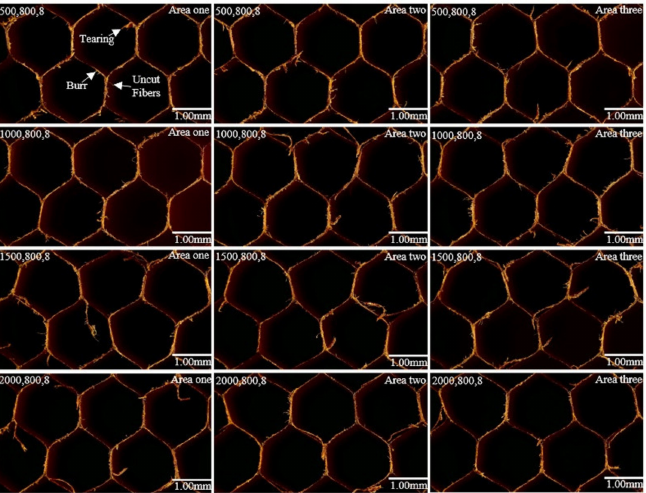
Figure 19. Surface morphology at different feed rates.